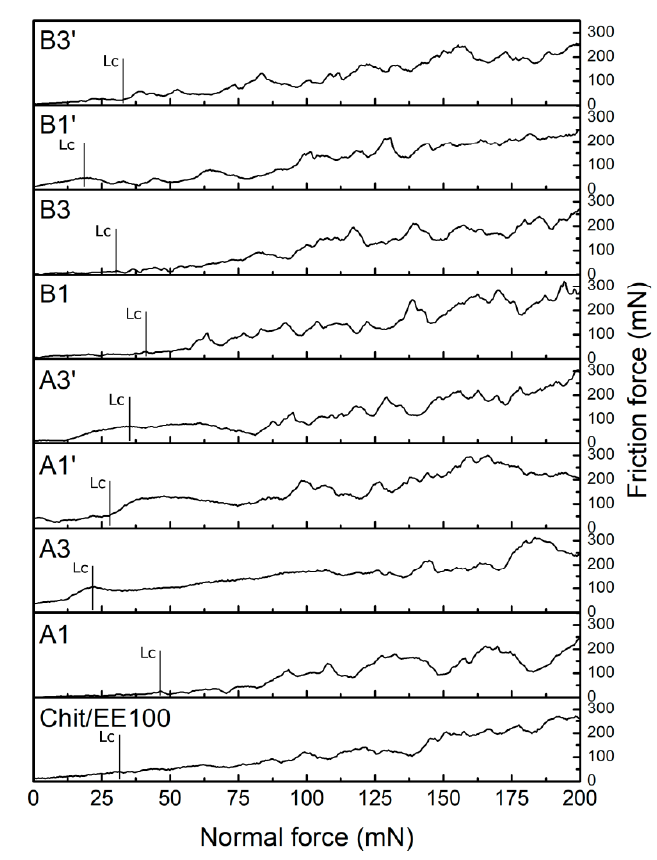
Figure 7. The friction force versus normal force dependence obtained for chit/EE100 and chit/EE100/AgNPs coatings along with an indication of the critical force ( Lc ) leading to complete delamination of the coating from the titanium